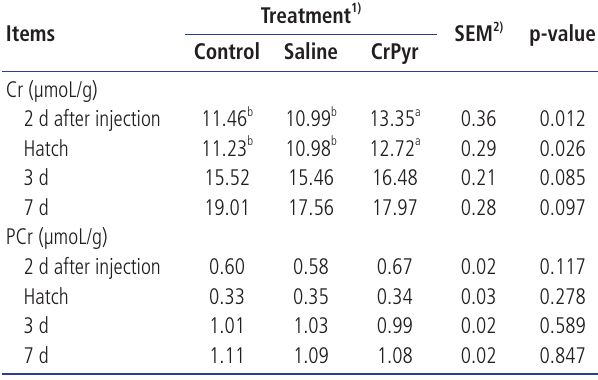
Table 7. Effects of in ovo feeding of creatine pyruvate on the hexokinase and pyruvate kinase activities in thigh muscle of embryos and broilers on 2 d after injection, the day of hatch, 3, and 7 d post-hatch Treatment 1) Items SEM 2)